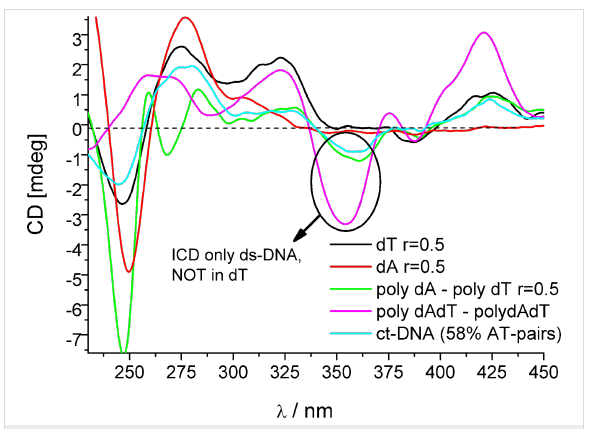
Figure 3: Comparison of AP3 ICD bands for ss-DNA (dA and dT) with alternating- and homo-AT ds-polynucleotides, as well as mixed sequence DNA (ct-DNA, 58% of